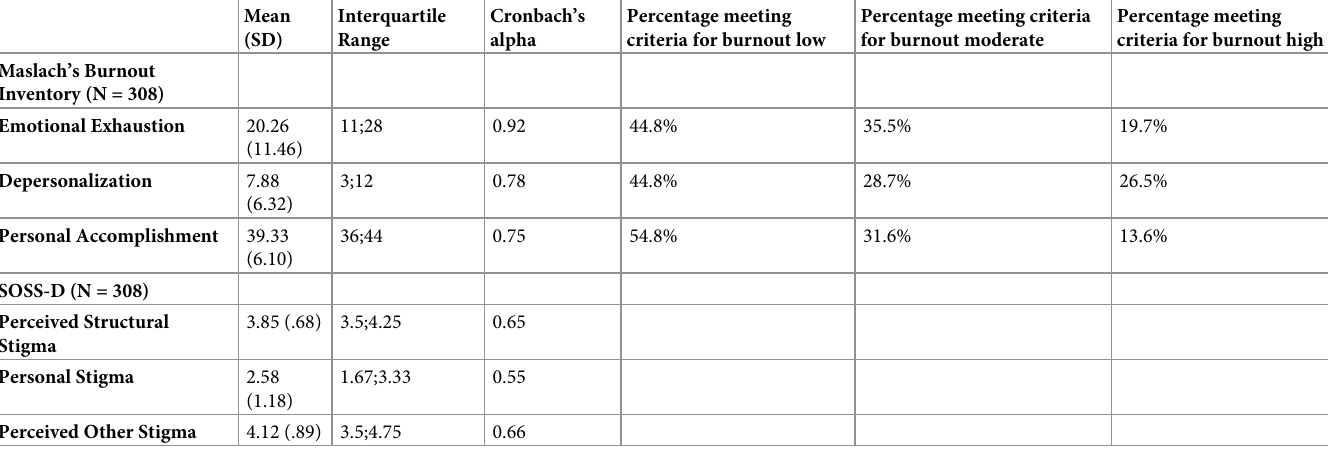
Table 1. Descriptive Scale Statistics Maslach’s Burnout Inventory and